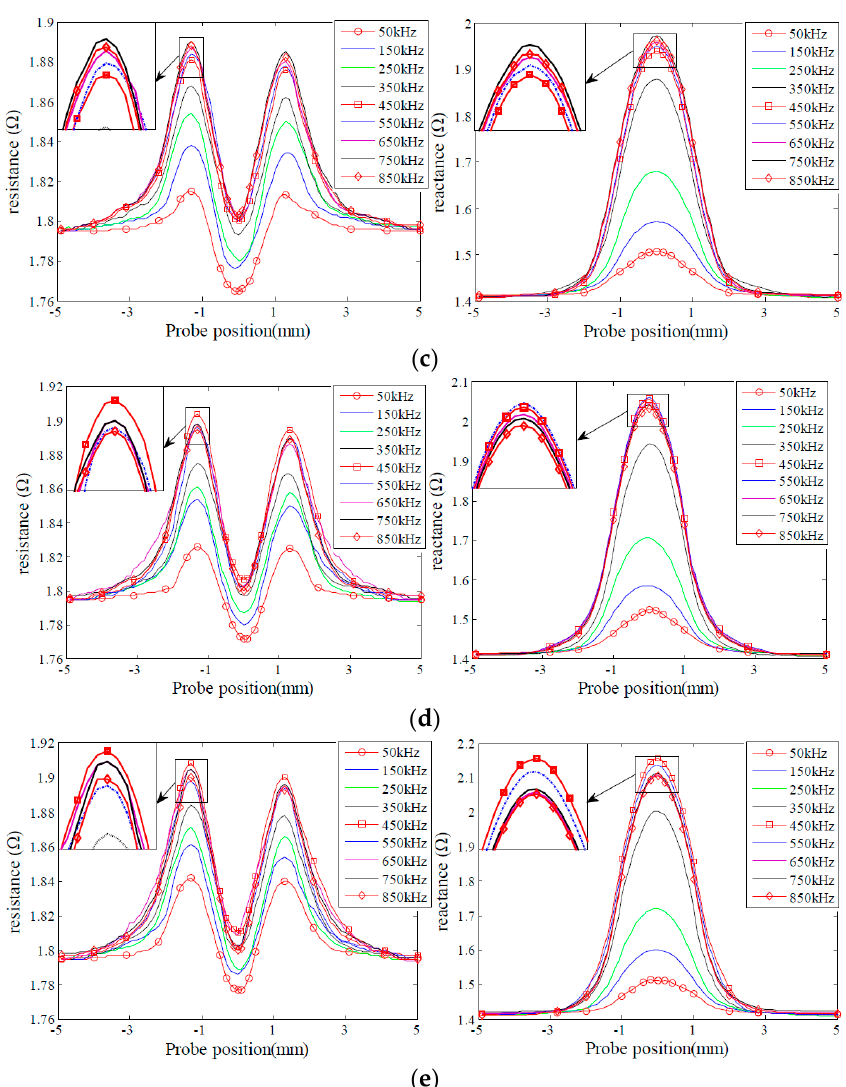
Figure 3. Probe signals due to the defects with different depths. ( a ) Probe signals of the defect D1; ( b ) probe signals of the defect D2; ( c ) probe signals of the defect D3; ( d ) probe signals of the defect D4; ( e ) probe signals of the defect D5.